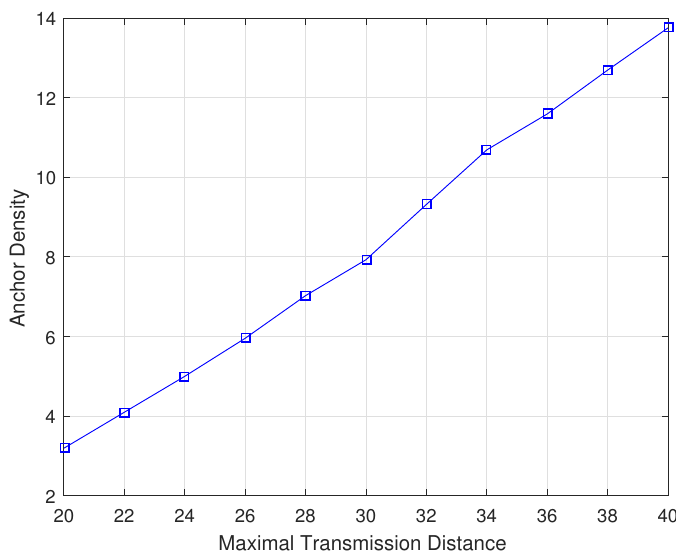
Figure 8. Anchor density with transmission range ( n = 80, m =